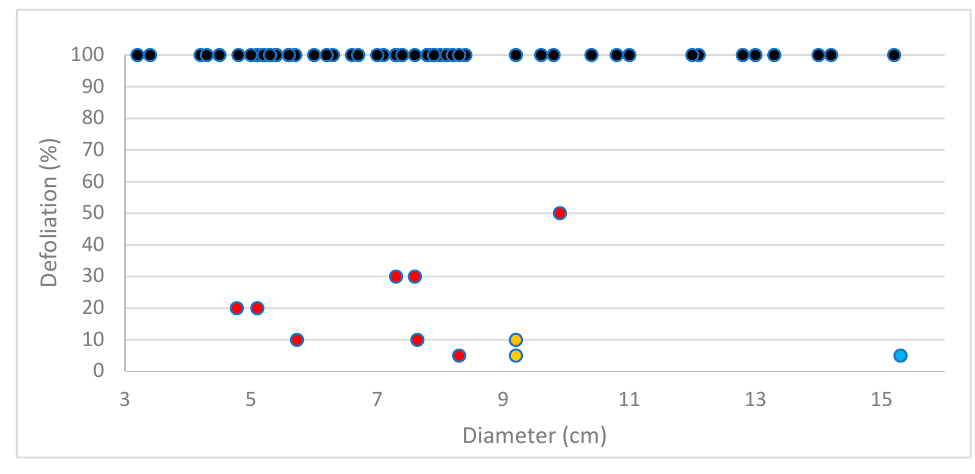
Figure 9. Selection of U. glabra trees that are tolerant to O . novo-ulmi and the local environmental conditions (forest field) {II-blue: D > Dm + s, III-orange: D > Dm, black dots: dead, and red dots: not selected trees}.